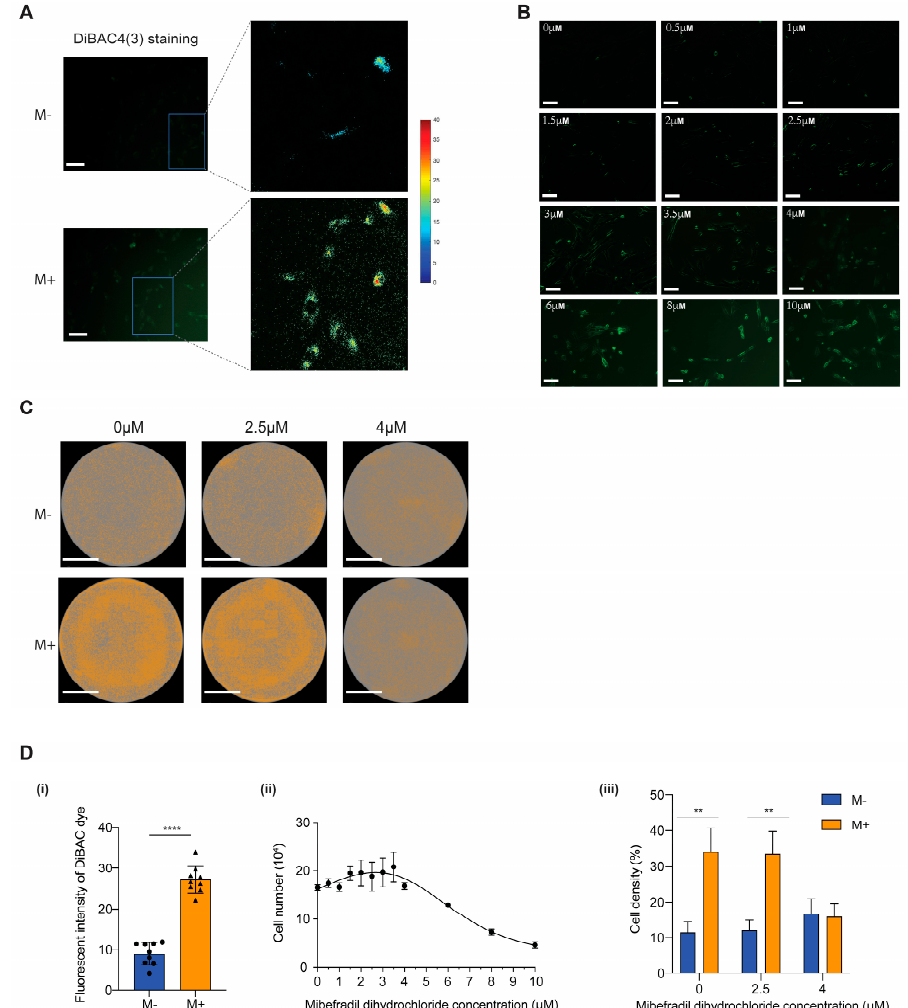
Figure 4. The SMF affects membrane depolarization via the T-type calcium ion channel. ( A ) The spa- tial distribution of V mem across MSCs can be visualized by voltage-sensitive reporter dyes DiBAC 4 (3) to reveal depolarization when cells are exposed to SMF. The color bar indicates the fluores- cent intensity of DiBAC 4 (3) dye. ( B ) The intensity of voltage-sensitive reporter dye DiBAC 4 (3) signal of MSCs treated with T-type Ca 2+ channel blocker (CCB) mibefradil dihydrochloride. The fluores- cence of the dye indicates the degree of depolarization. Scale bars, 100 μ m. ( C ) Images of whole- well cell distributions when treated with different concentrations of CCB under an M+/M − environ- ment. Scale bars, 10 mm. ( D ) Statistical analysis of Figure 4 A–C. (i) Bar chart indicating the intensity of voltage-sensitive reporter dye DiBAC 4 (3) signal di ff erence between M+ and M − . (ii) Graph show- ing the relationship between cell number and mibefradil dihydrochloride concentration. (iii) Bar chart indicating the cell density of MSCs treated with different concentrations of CCB under an M+/M − environment. Asterisks indicate statistical significance of the separation between the mean of the medians according to unpaired two-tailed t -test between conditions. ns p > 0.05; ** p < 0.01; **** p < 0.0001. The T-type calcium channel is a low-voltage-activated calcium channel that becomes inactivated during cell membrane hyperpolarization but then opens during